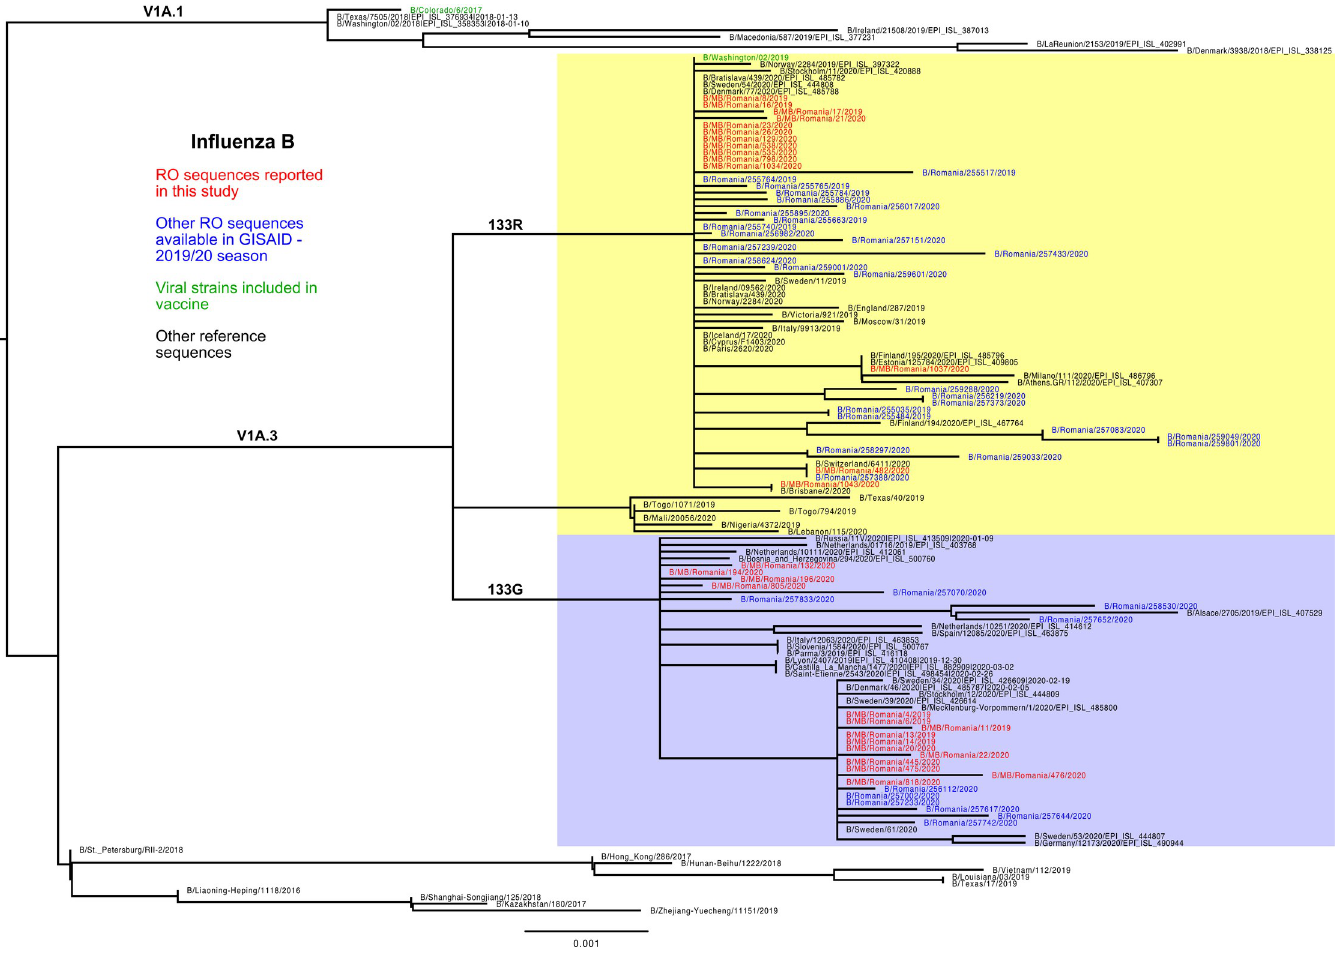
Fig 5. Phylogenetic analysis of B/Victoria hemagglutinin